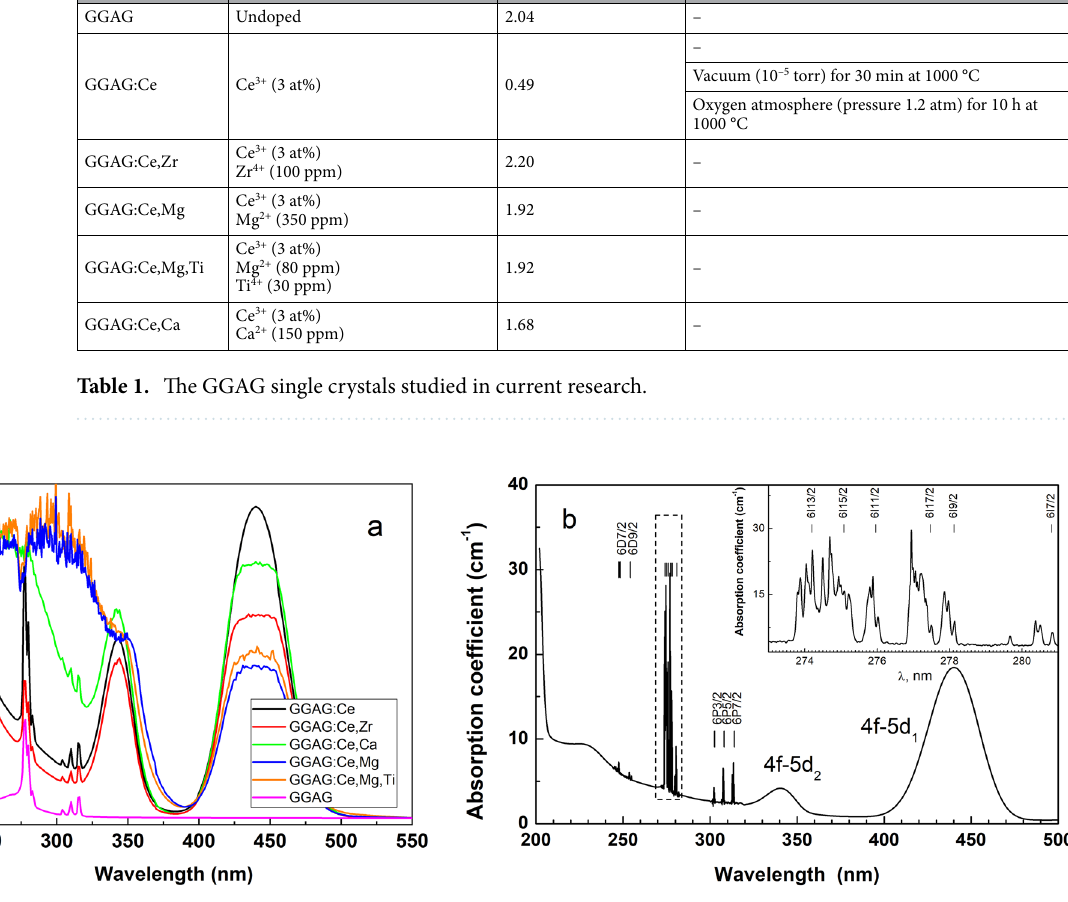
Figure 1. The absorption spectra of the co-doped GGAG:Ce single crystals at room temperature ( a ). The spectrum for the undoped crystal is given for comparison. The absorption spectrum for the cerium doped GGAG single crystal at 10 K is shown in ( b ). The inset reveals a fine structure of Gd 3+ transitions in the dashed area. Gd 3+ absorption lines are assigned to energy levels reported in 40